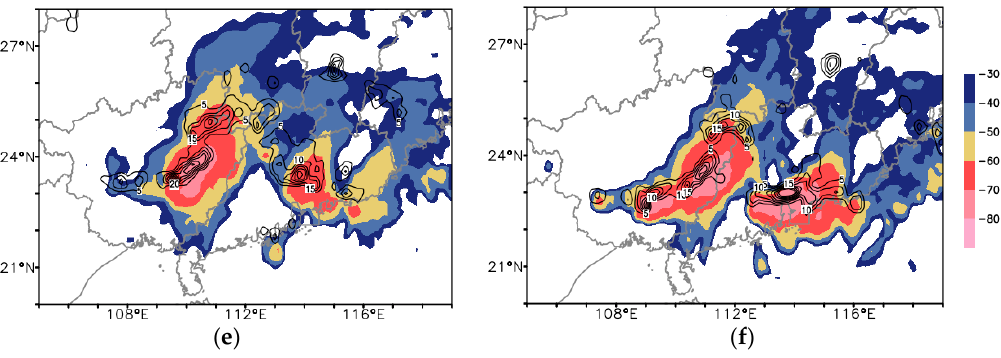
Figure 3. Hourly distribution of precipitation and TBB less than − 30 °C derived from China’s FY-geostationary satellite at ( a ) 1900 UTC, ( b ) 2100, ( c ) 2300 UTC 19 May, ( d ) 0100, ( e ) 0300 and ( f ) 0500 UTC 20 May in 2-h intervals; the lines represent the precipitation, and the shaded regions represent the TBB (°C).